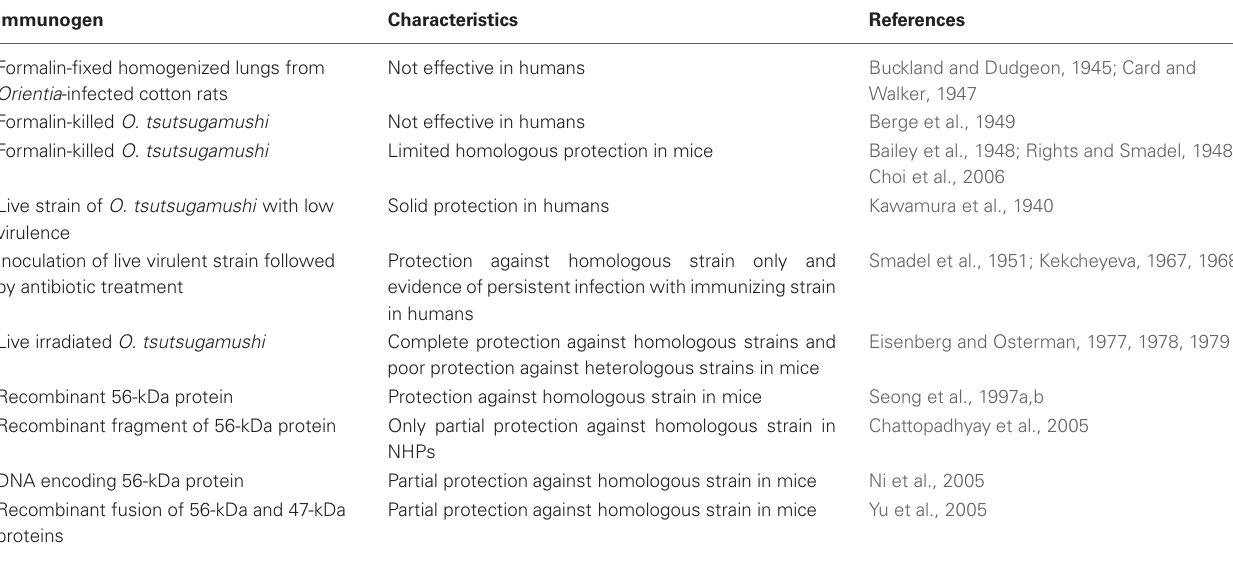
Table 2 | Vaccines for scrub